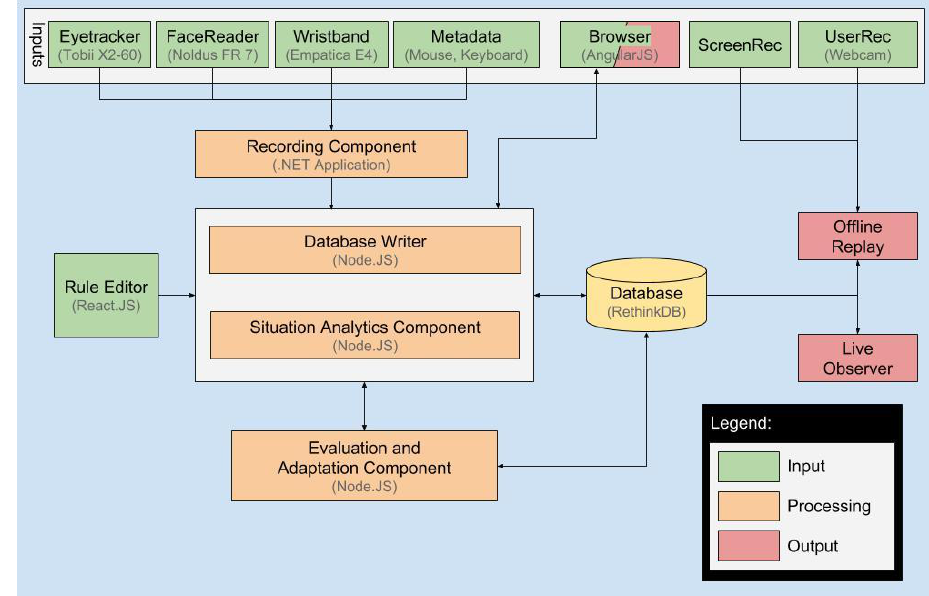
Figure 1. Structure and compoments of the SitAdapt Interpreter in its current implementation